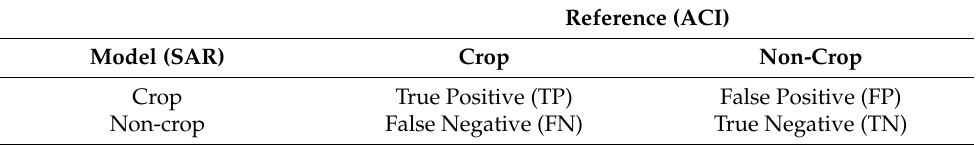
Table 4. Confusion matrix for crop and non-crop